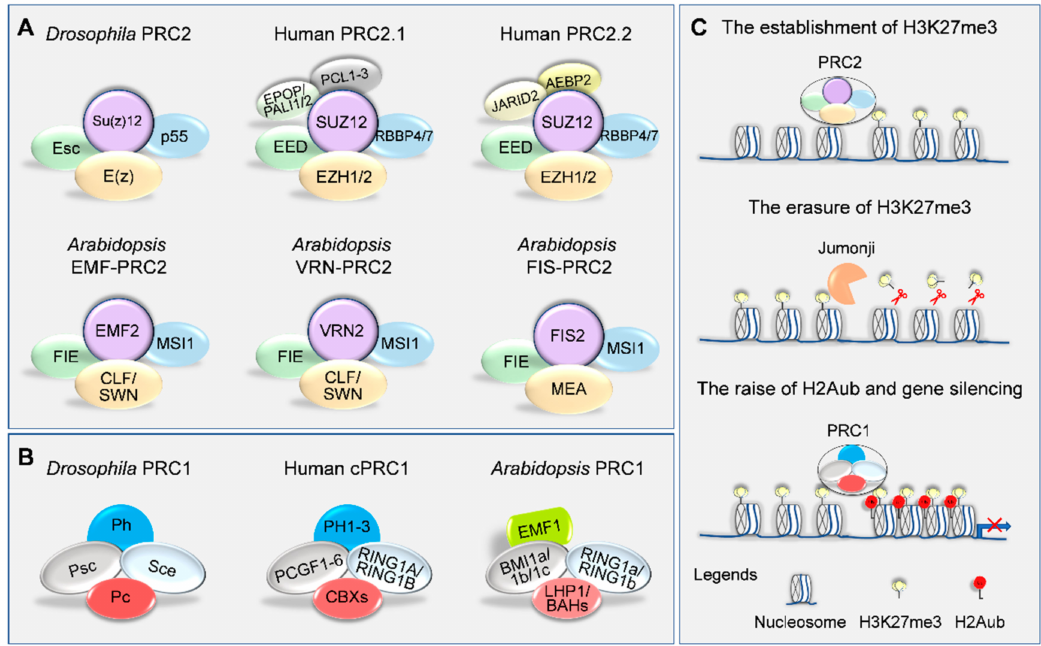
Figure 1. Core PRCs and their chromatin-modifying activities. ( A , B ) Compositions of the polycomb repressive complexes PRC2 ( A ) and PRC1 ( B ) in animals and plants, where Drosophila, human, and Arabidopsis were taken as representatives. ( C ) Schematic representation of the H3K27me3 deposition, erasure, and its roles in gene silencing. Acronyms and further details are explained in the